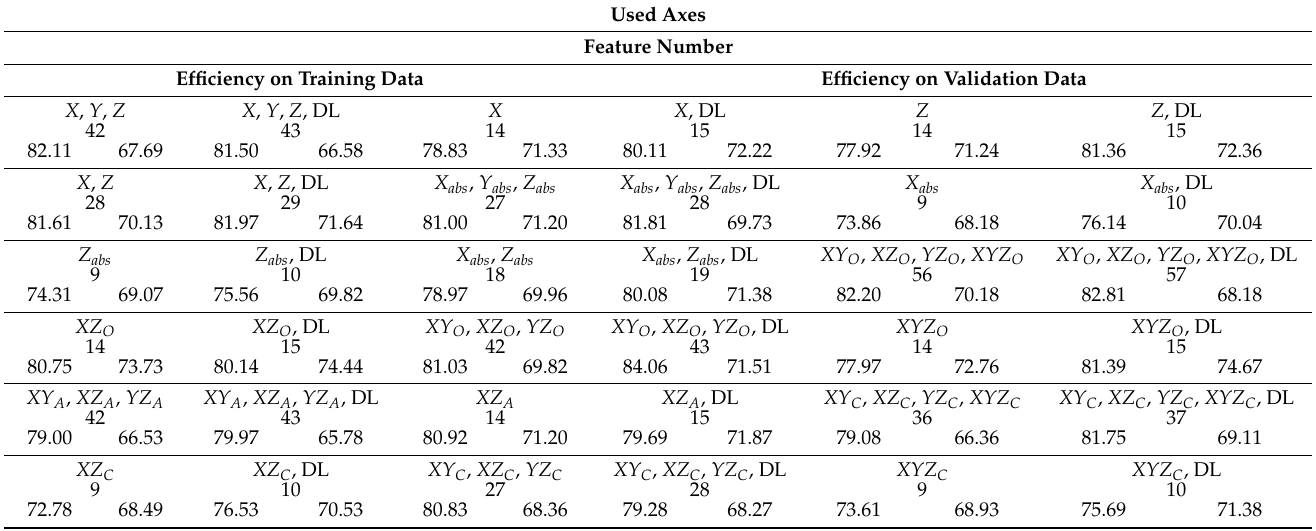
Table 6. Feature numbers and average recognition efficiencies (%) on training and validation data for different setups. Used Axes